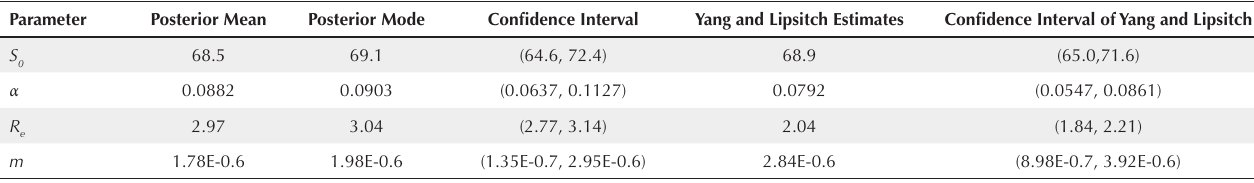
Table 1. Parameter Estimates and Confidence Intervals of 95% Compared With the Posterior of Yang and Lipsitch Parameter Posterior Mean Posterior